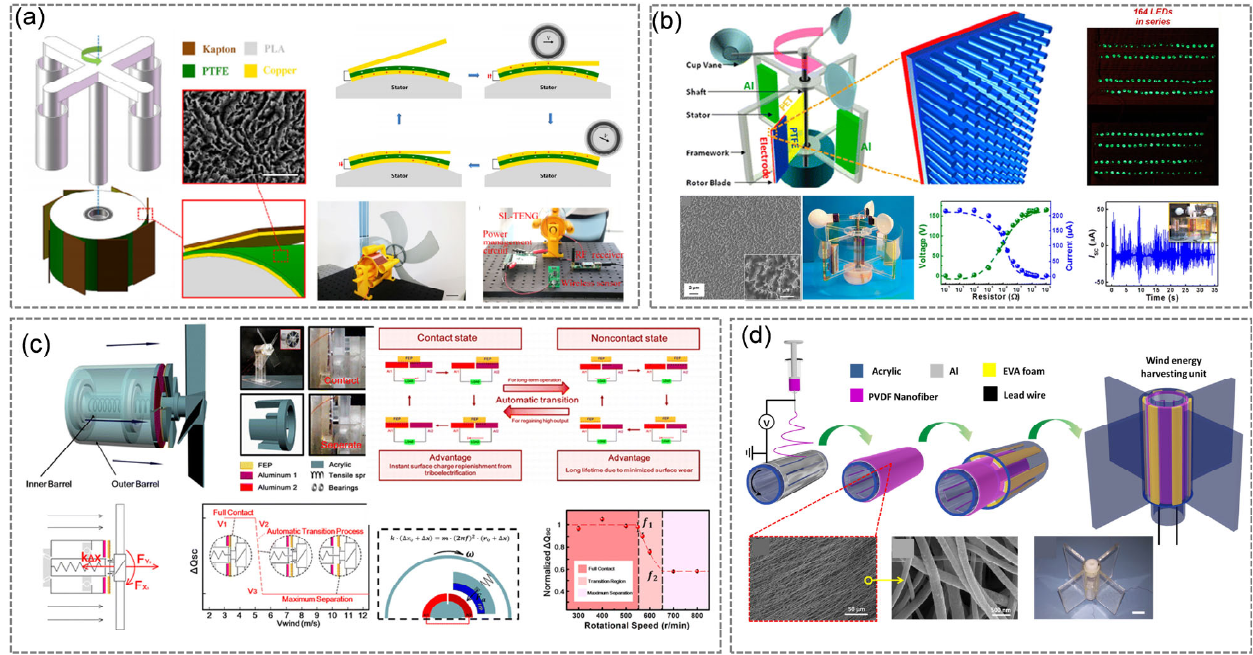
Figure 4. Rotary ‐ based mechanism: ( a ) CS ‐ mode TENG with single direction rotation (reproduced with permission [40]. Copyright 2018, Nano Research ). ( b ) CS ‐ mode TENG with double direction rotation (reproduced with permission [41]. Copyright 2013, ACS Nano ). ( c ) FS ‐ mode TENG through automatic transition between contact and noncontact working states (reproduced with permission [42]. Copyright 2015, ACS Nano ). ( d ) Coaxial rotatory FS ‐ mode TENG (reproduced with permission [43]. Copyright 2018, Nano Energy ).